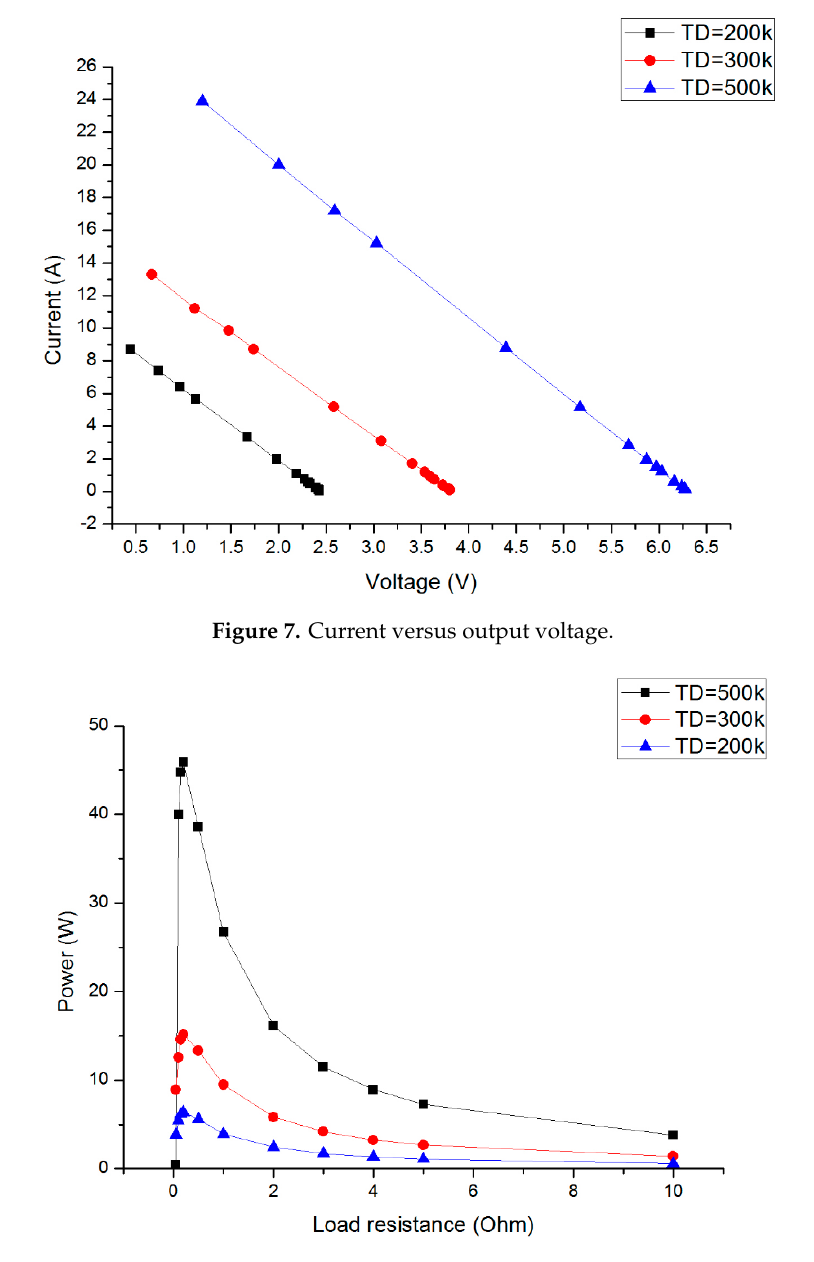
Figure 8. Output power versus load resistance.